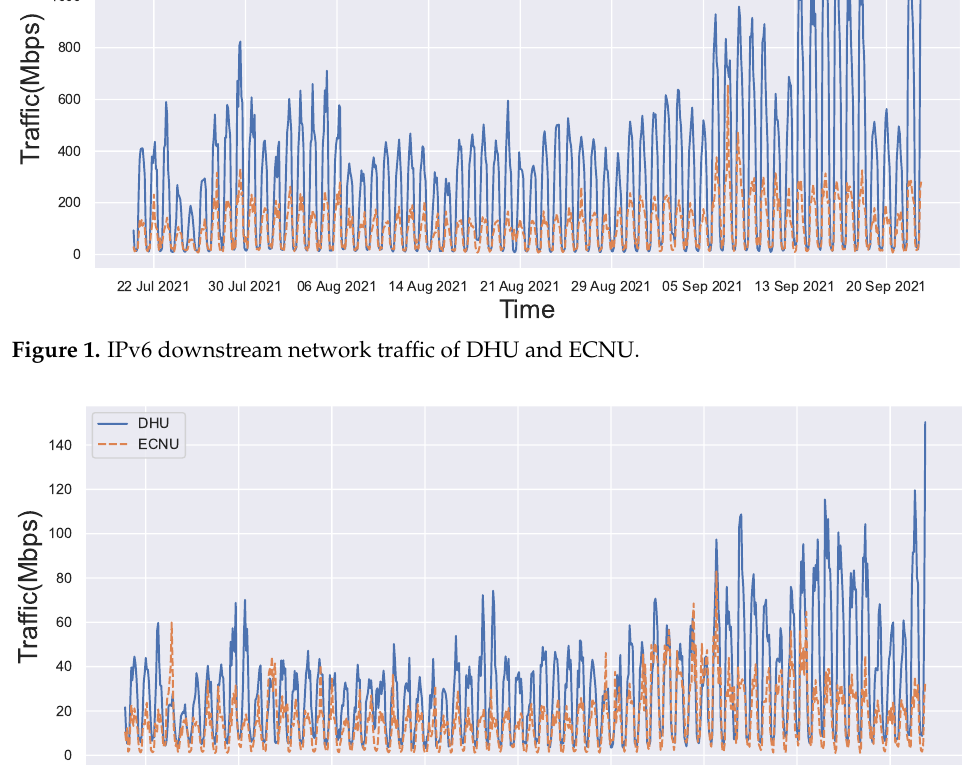
Figure 2. IPv6 upstream network traffic of DHU and